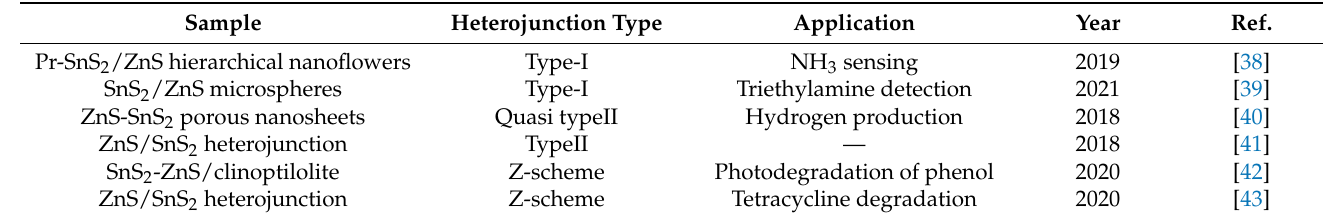
Table 1. Some studies on SnS 2 /ZnS heterojunction for various